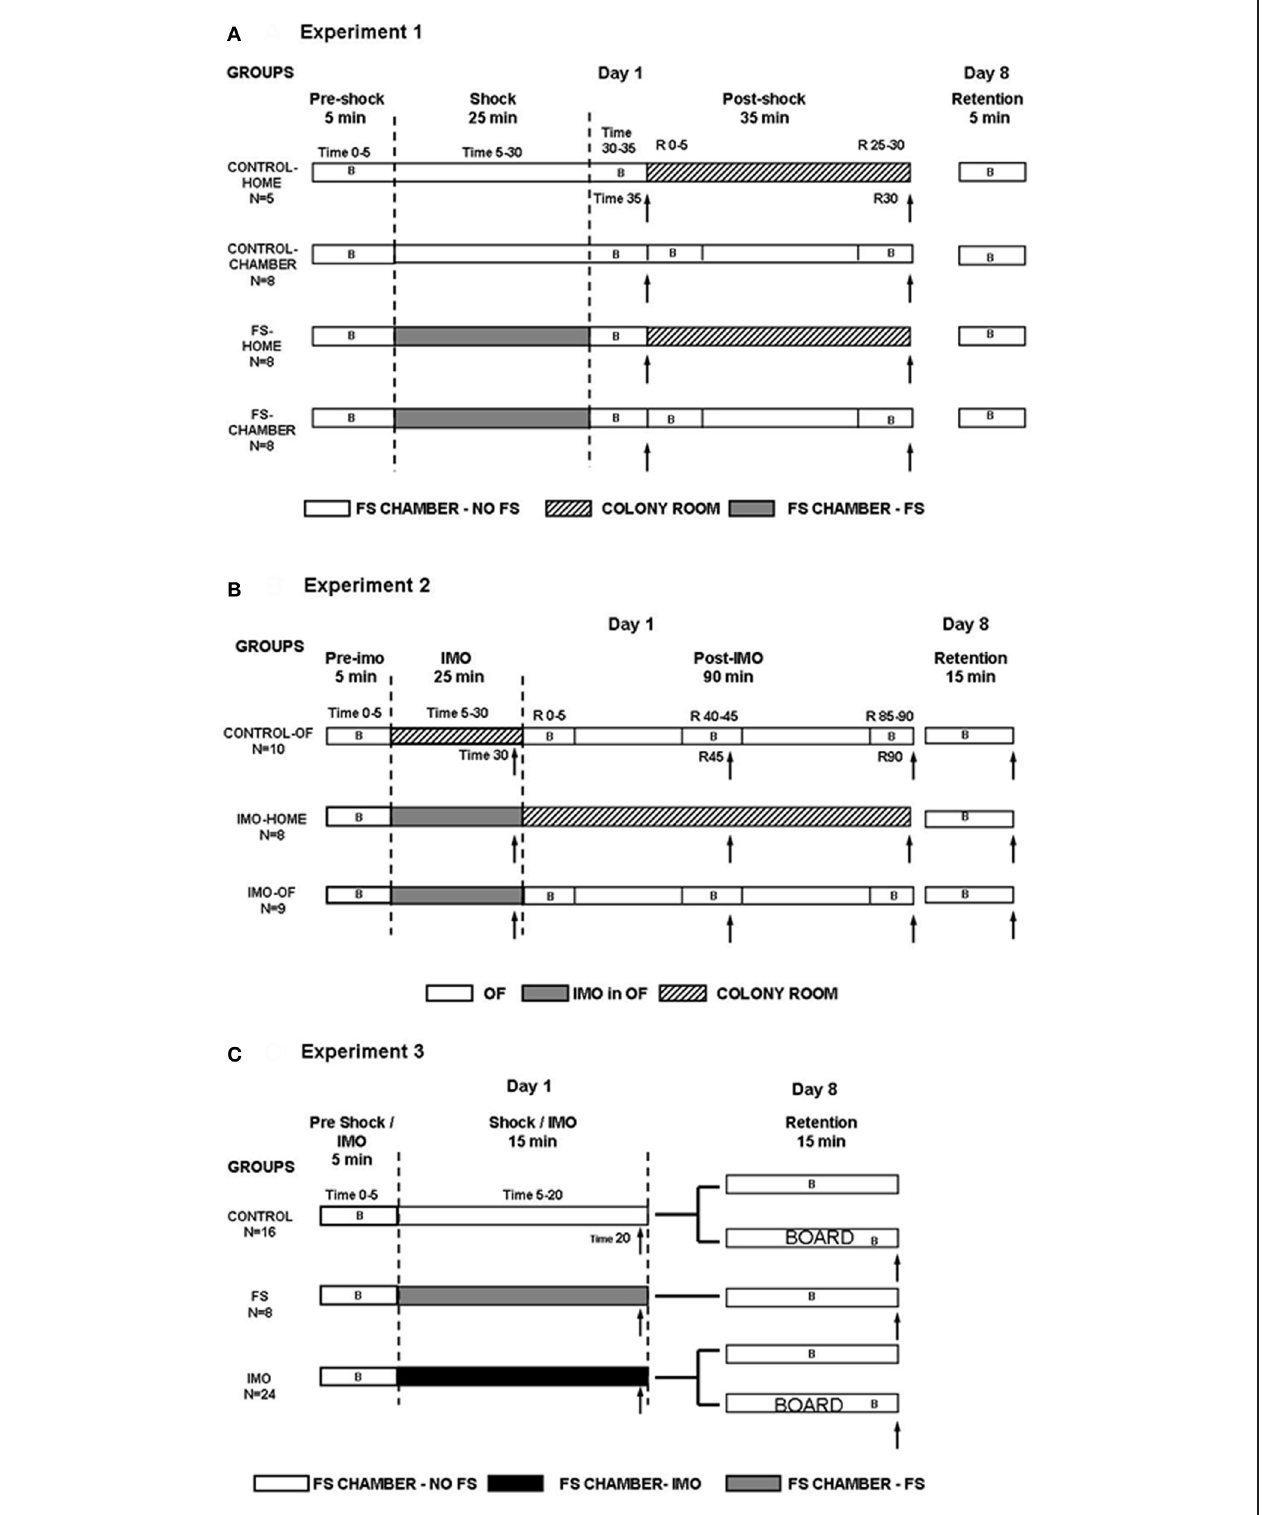
FIGURE 1 | Summary of the experimental design for Experiment 1 (A), Experiment 2 (B), and Experiment 3 (C). B: periods of behavioral assessment. ↑ , blood sampling.